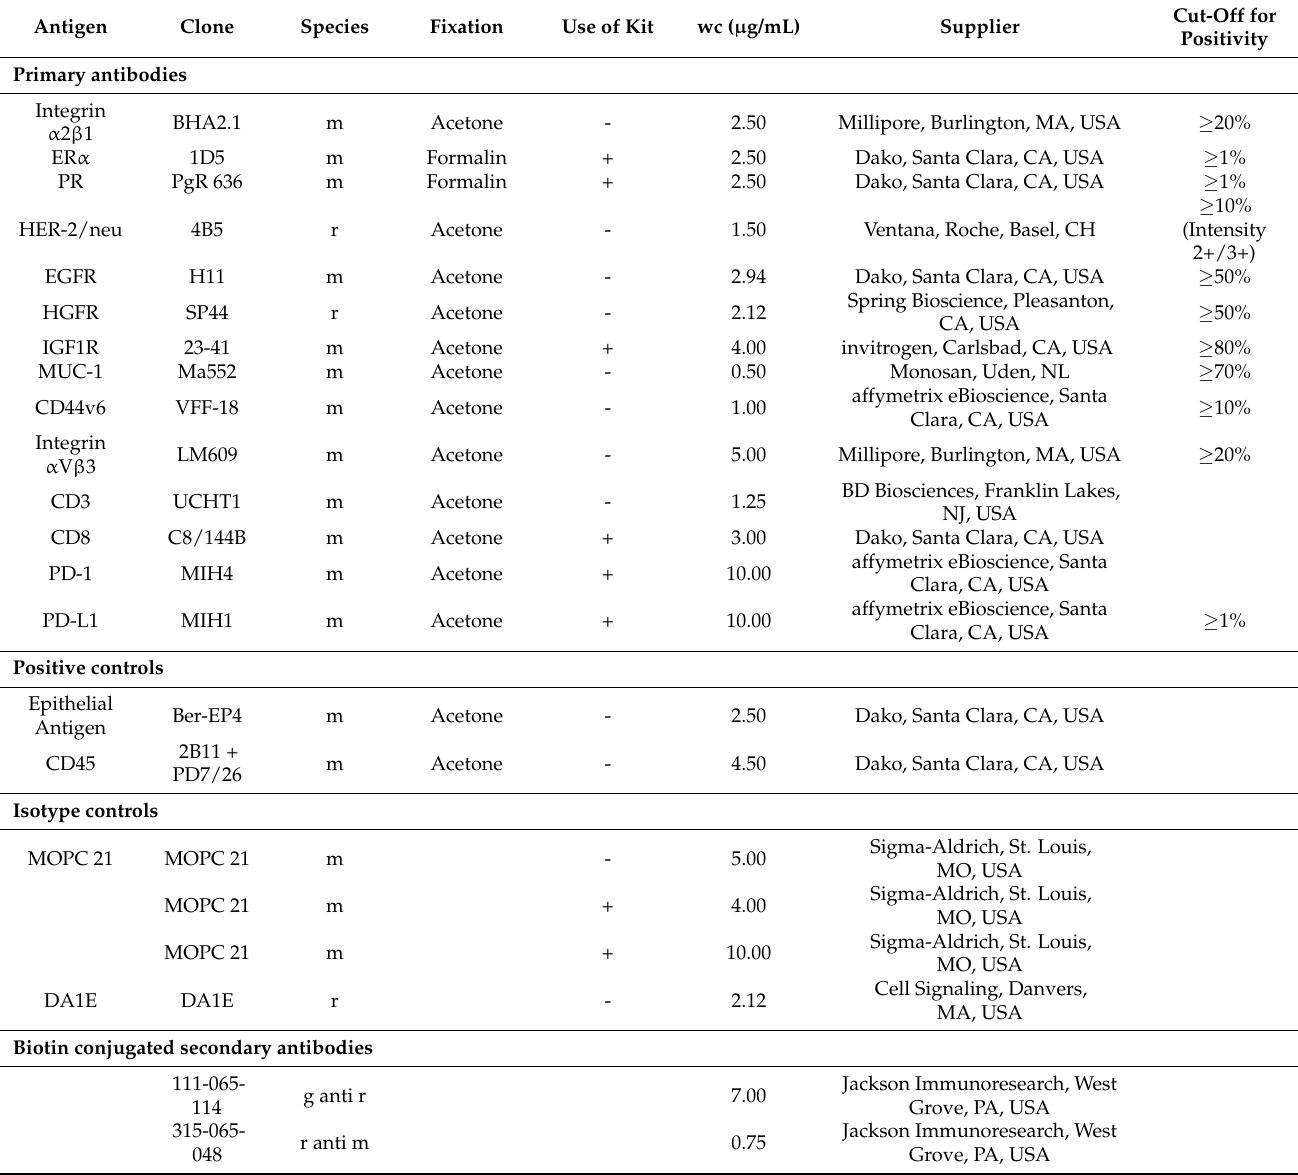
Table 1. Biomarkers and